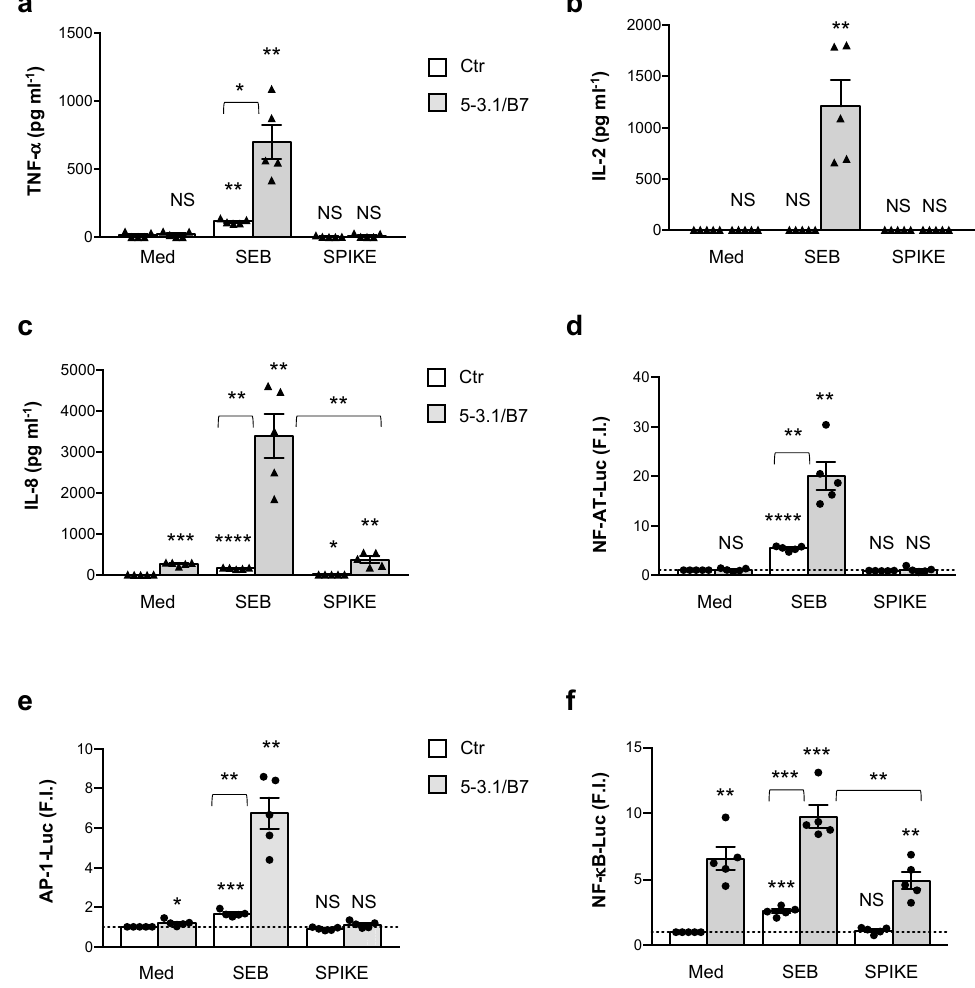
Figure 1. SARS-CoV-2 spike does not stimulate inflammatory pathways in Jurkat cells expressing CD28 and TCRVb3.1. ( a – c ) CH7C17 Jurkat cells expressing CD28 and TCRV β 3.1 (n = 5) were cultured for 24 h with medium alone (Med) or 1 µ g mL − 1 of SEB or 1 µ g mL − 1 SARS-CoV-2 spike in the absence (Ctr) or presence of 5-3.1/B7 cells expressing human HLA-DR1 and B7.1/CD80 molecules. TNF- α ( a ), IL-2 ( b ) and IL-8 ( c ) secretion in culture supernatants was measured by ELISA. Data show the mean ± SEM, and statistical significance was calculated by one-way ANOVA. ( d – f ) Jurkat cells (n = 5) were transfected with 5 µ g GFP together with 10 µ g NF-AT-luciferase (Luc) ( d ), or 10 µ g AP-1-Luc ( e ) or 2 µ g NF- κ B-Luc ( f ) constructs and then unstimulated (Ctr) or stimulated for 6 h with SEB or SARS-CoV-2 spike alone or in the presence of 5-3.1/B7 cells. The results were expressed as fold inductions (F.I.) over the basal level of luciferase activity in unstimulated cells after